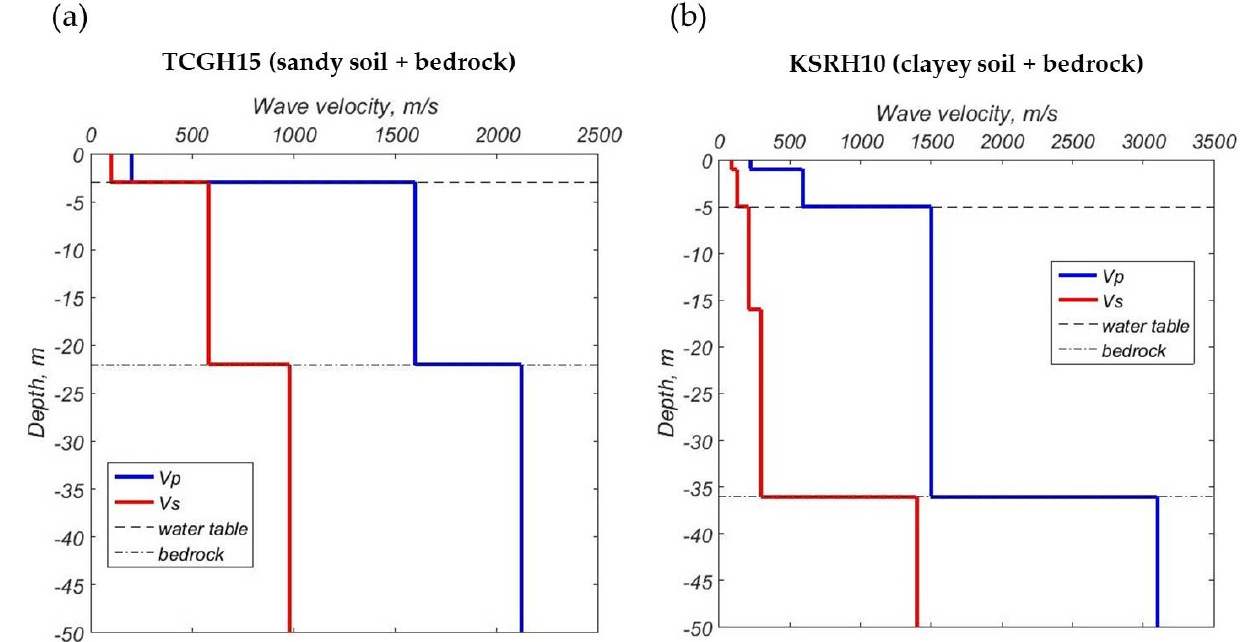
Figure 7. Velocity profiles at sites TCGH15 ( a ) and KSRH10 ( b ) of the Kik-net network. For most cases, only velocity profiles are available in the database [26]. Other ge- otechnical parameters were calculated according to various equations (Tables 1 and 2).